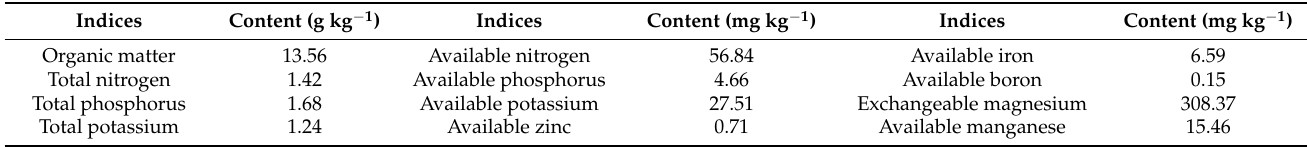
Table 1. The fertility information of soils in R. roxburghii orchard .